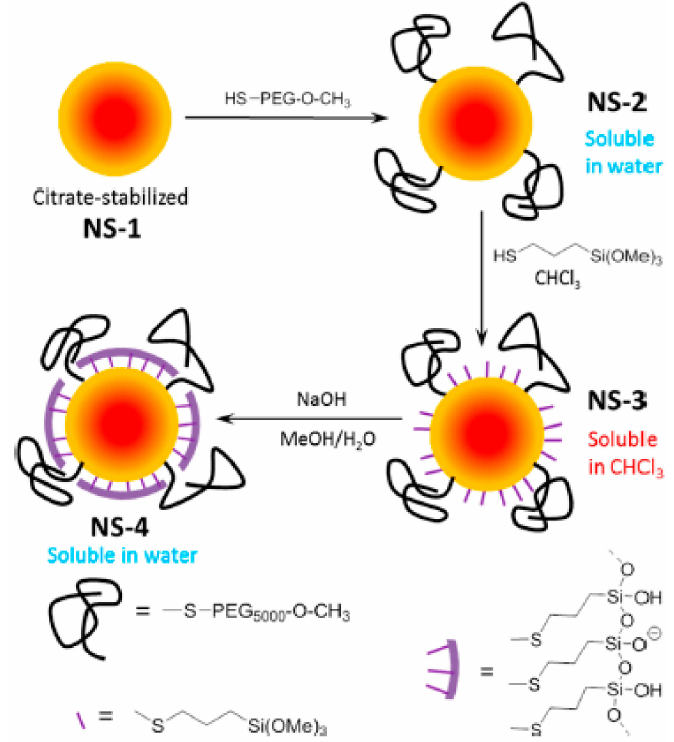
Figure 4. Synthetic protocol of Au nanoparticles carrying a dual PEG-Silica monolayer shell, which provided a high colloidal and chemical stability and improved antifouling properties. Reprinted with permission from reference [44]. Copyright (2019) American Chemical